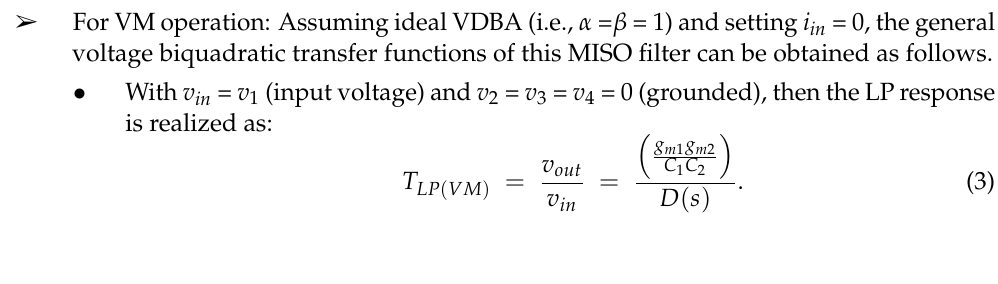
Figure 3. Proposed mixed-mode biquadratic filter using